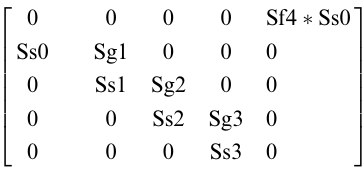
Table 1. Number of Ohlone tiger beetle eggs and first instars marked (all quadrats combined), number of adults counted, and growth and survival parameters for each stage and site (see text for parameter explanation and calculation method).